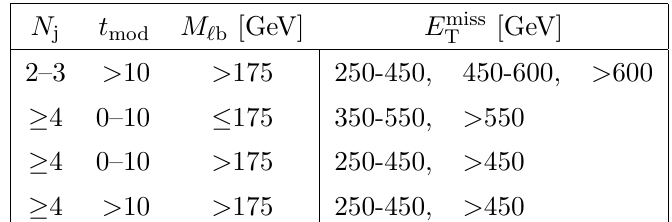
Table 4 . Dilepton control regions utilizing combined bins in E miss